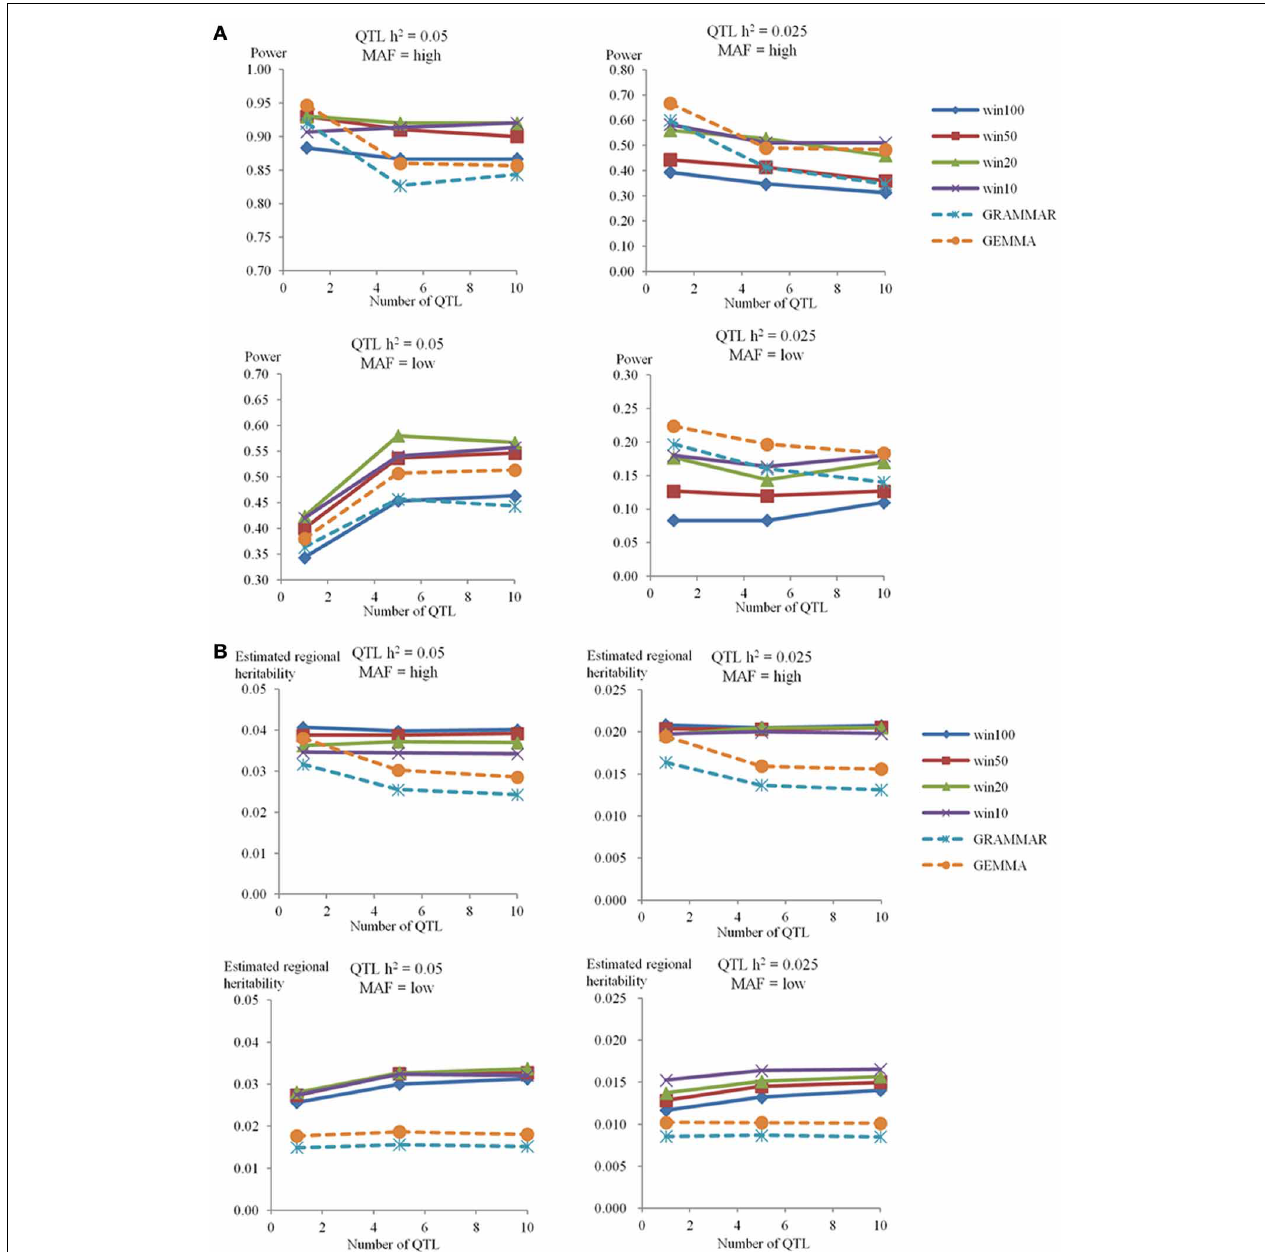
FIGURE 2 | The power to achieve 5% genome-wide significance and estimated regional heritability in the 100-SNP window. The powers (A) and estimated regional heritabilities (B) in the simulation study for genome heritability 0.4 were calculated by RHM with four different window sizes (100 SNPs as win100, 50 SNPs as win50, 20 SNPs as win20, and 10 SNPs as